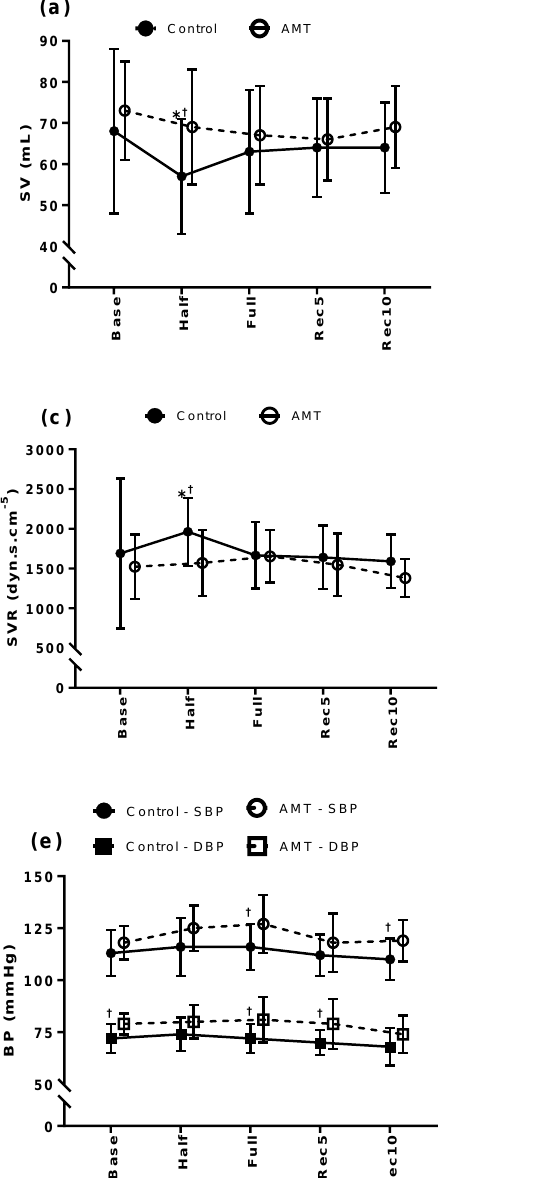
Figure 1. (a) Stroke volume (SV), (b) cardiac output (CO), (c) systemic vascular resistance (SVR), (d) heart rate (HR) and (e) systolic and diastolic blood pressure (SBP and DBP) during blood donation for control and AMT groups. Data points are presented as mean ± SD. Base = baseline; Half = 50% donated; Full = 100% donated; Rec5 = after 5 min in recovery; Rec10 = after 10 min in recovery. * denotes significant difference from baseline ( p < 0.05) and † denotes significant difference between groups ( p < 0.05).